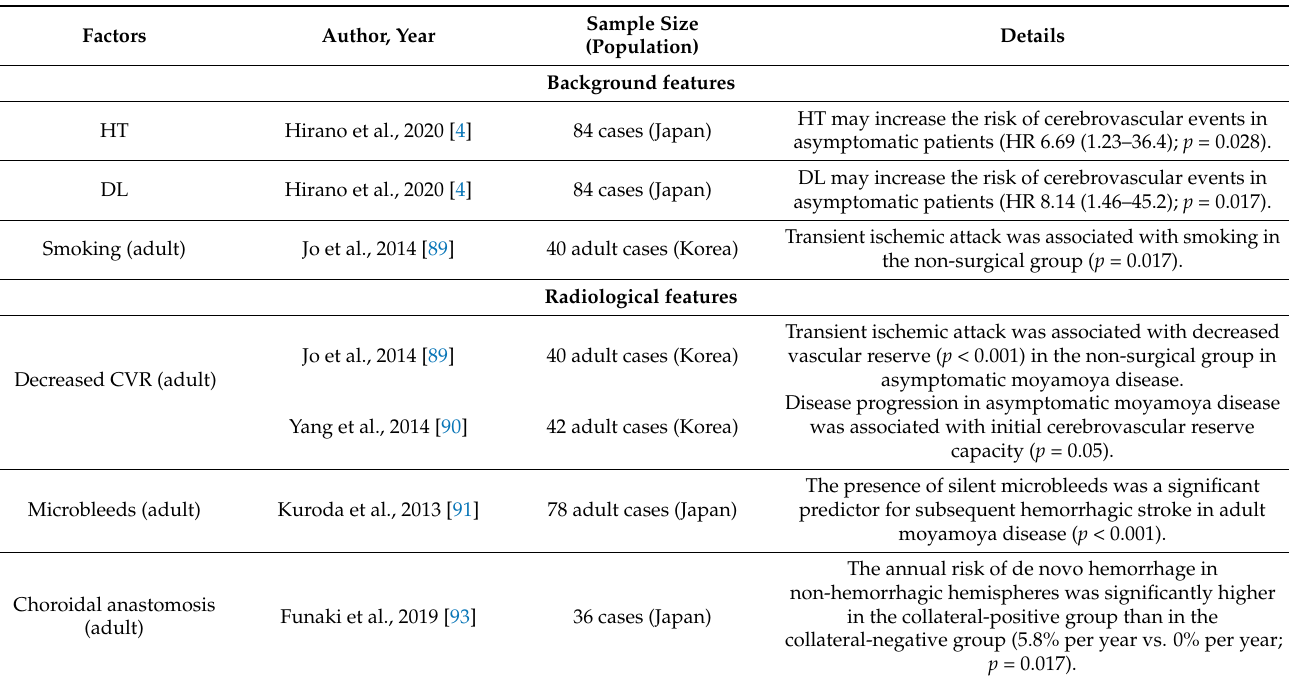
Table 6. Factors associated with cerebrovascular events in asymptomatic moyamoya disease.